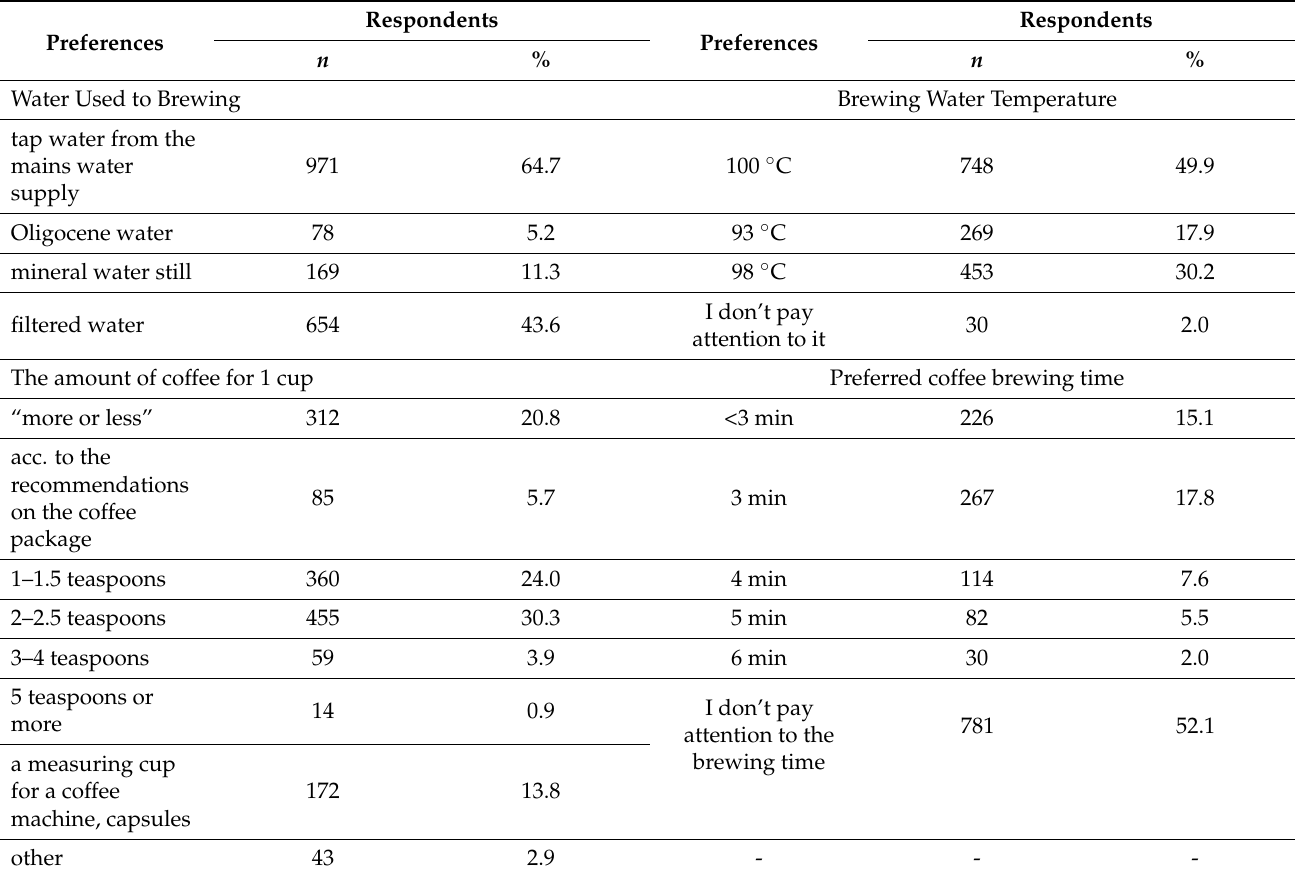
Table 6. Respondents’ preferences for the preparation of coffee